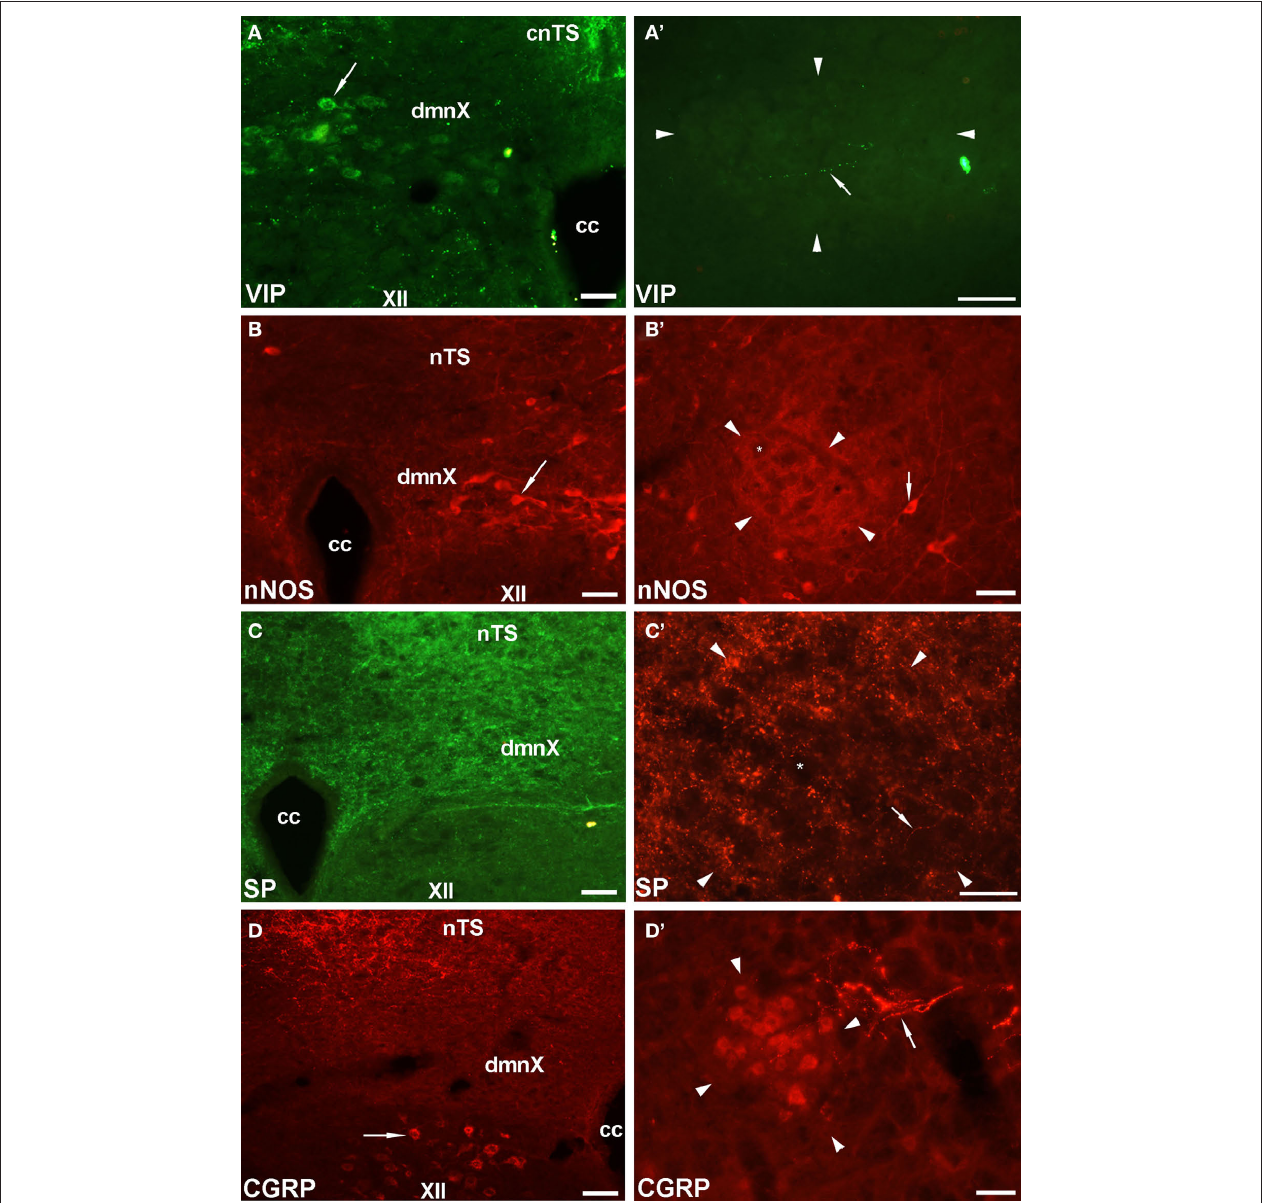
soma in either the dmnX or nAmb, but was expressed by many fine fibers in both nuclei (arrow). (D) CGRP was not expressed in dmnX neurons. Fibers in the adjacent nucleus of the solitary tract (nTS) and cells (arrow) in the hypoglossal nucleus (XII) were intensely CGRP positive. (D ′ ) CGRP expressing neurons were observed in the nAmb as well as some axons in close proximity (arrow). In (a ′ –D ′ ) the arrow heads delineate the boundary of the nAmb. The asterisks in (b ′ ,c ′ ) show the profile of unstained nAmb neurons. Note that different fluorophore-conjugated secondary antibodies were used, hence the red or green immunostaining. The scale bars represent 50 μm. Cc, central canal; cnTS, commissural